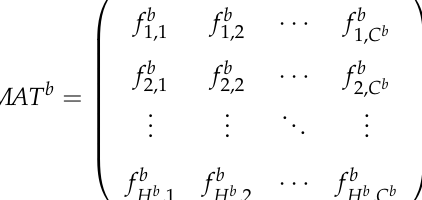
where H b and C b are the numbers of rows and columns in the matrix, respectively; and f b is the state feature of the phase-unrelated grid at the h th row and c th column, which is